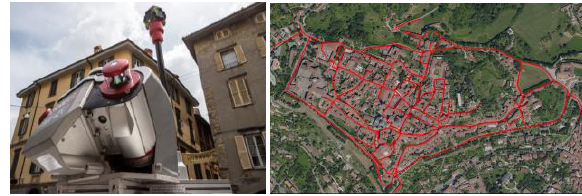
Figure 5. Configuration of the SINECO MMS (left) and the trajectory of the surveyed area (right).